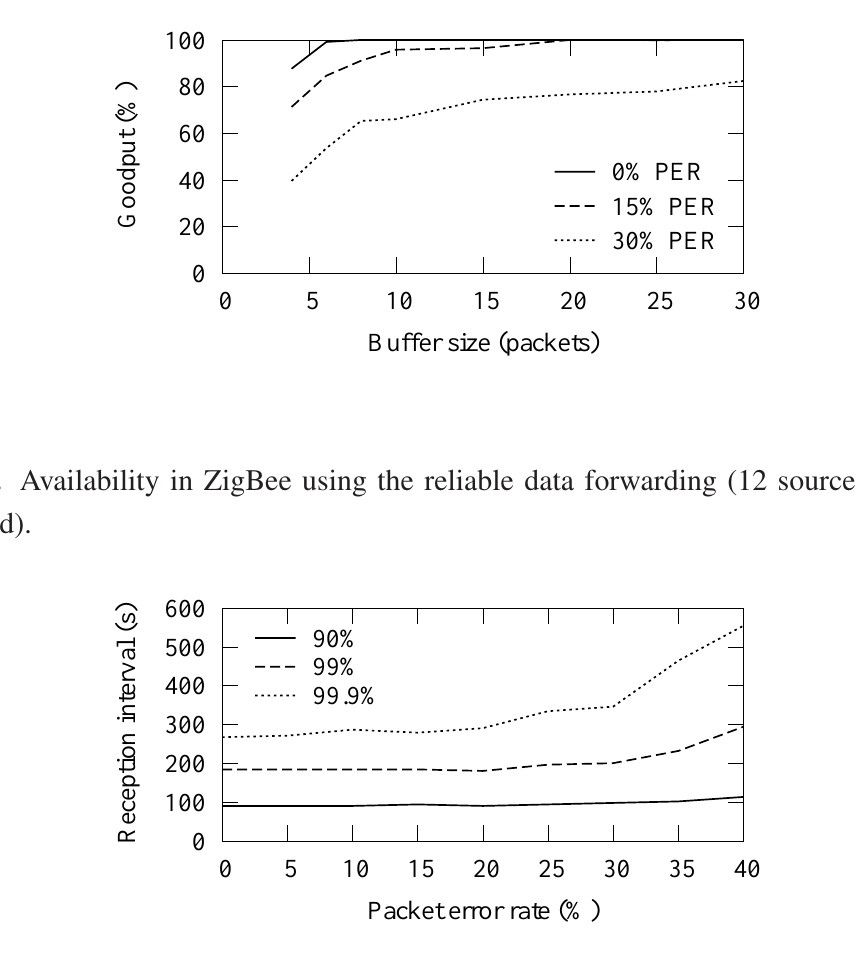
Figure 24. The effect of buffer size to the reliability in TUTWSN using the intermediate buffering scheme algorithm (12 sources, 15 B/s offered load).